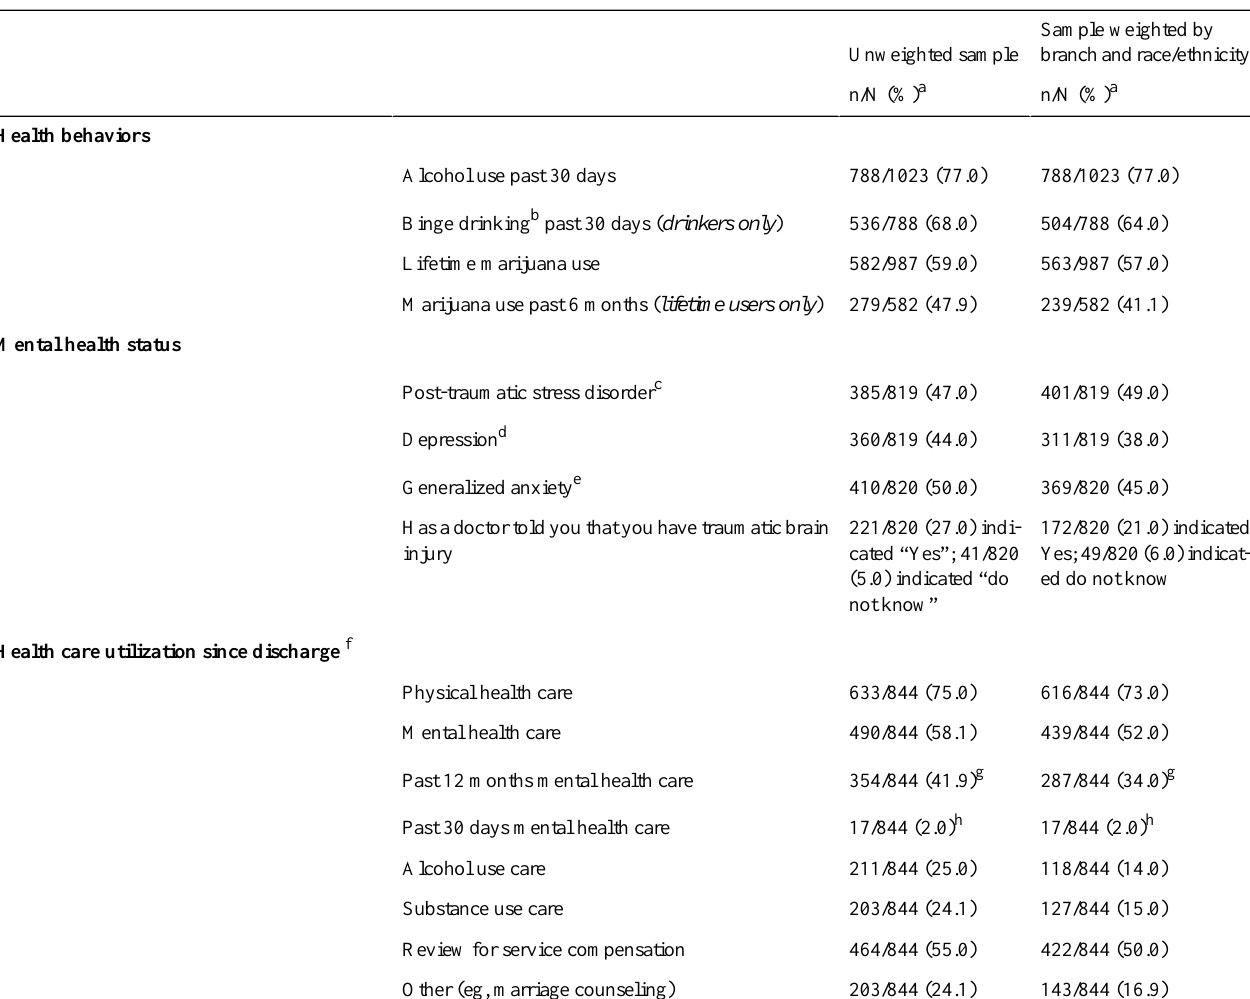
Table 2. Health behaviors, mental health status, and health care utilization of the unweighted Facebook sample and the Facebook sample weighted by branch and